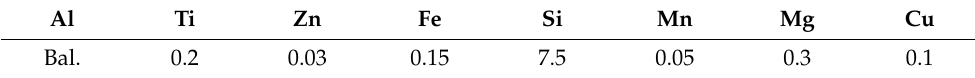
Figure 3. SEM image of nano-silica particles used in the study. Table 1. Chemical composition of A356 taken by Spark Optical Emission Spectrometry.